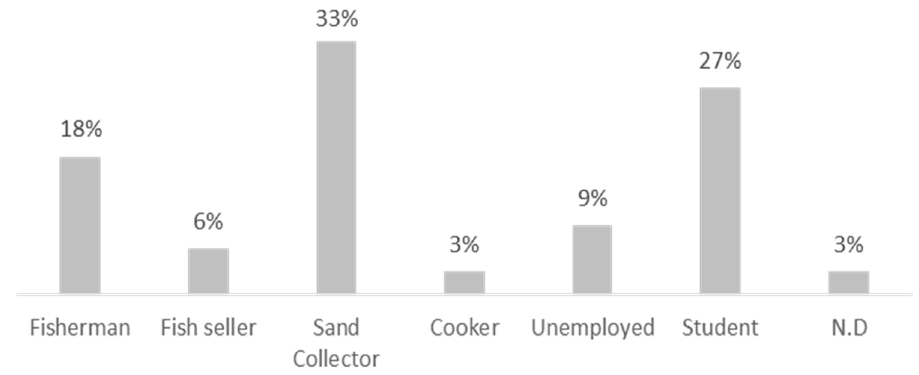
Figure 5. Participants in the group sessions by age group.